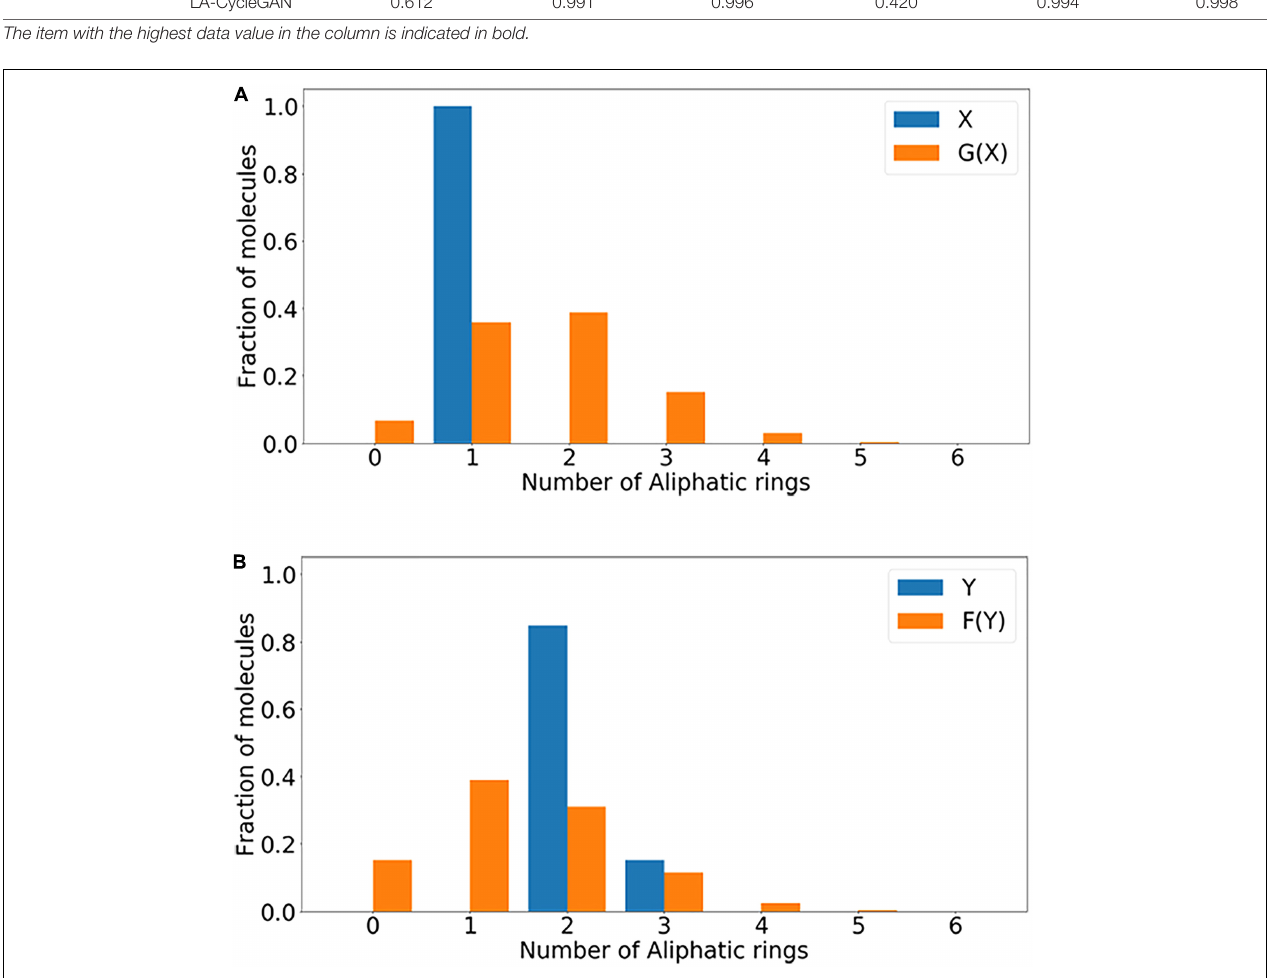
FIGURE 4 | The distribution of Aliphatic Rings that generate molecules. (A) Distribution of the number of Aliphatic Rings in X and G(X); (B) distribution of the number of Aliphatic Rings in Y and F(Y).